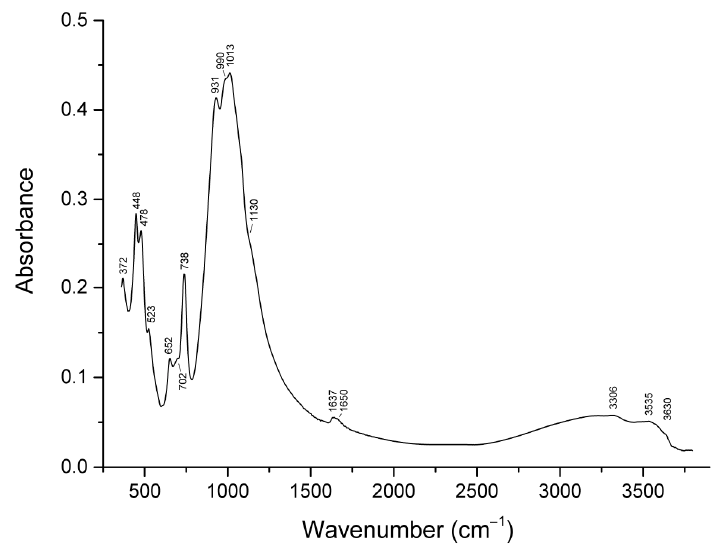
Figure 2. Infrared spectrum of the studied EGM sample.